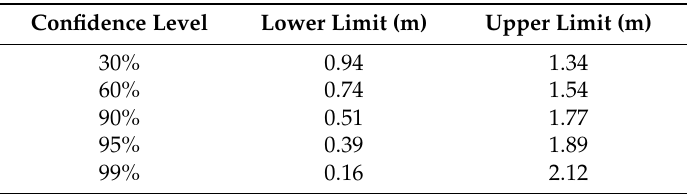
Table 5. Intervals of confidence for the WCPM relative SLR at epoch 2100 based on the cumulative density function of the PDF in Figure 9.